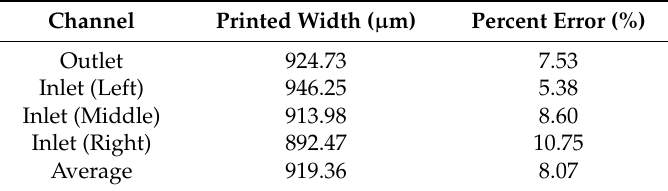
Table 2. Measurements and analysis of printing success of the final 3D-printed microfluidic chip design. The expected width of all channels was 1000 µ m. For all values presented, there was a measurement error of ± 0.01 µ m. The actual printed width and percent error are